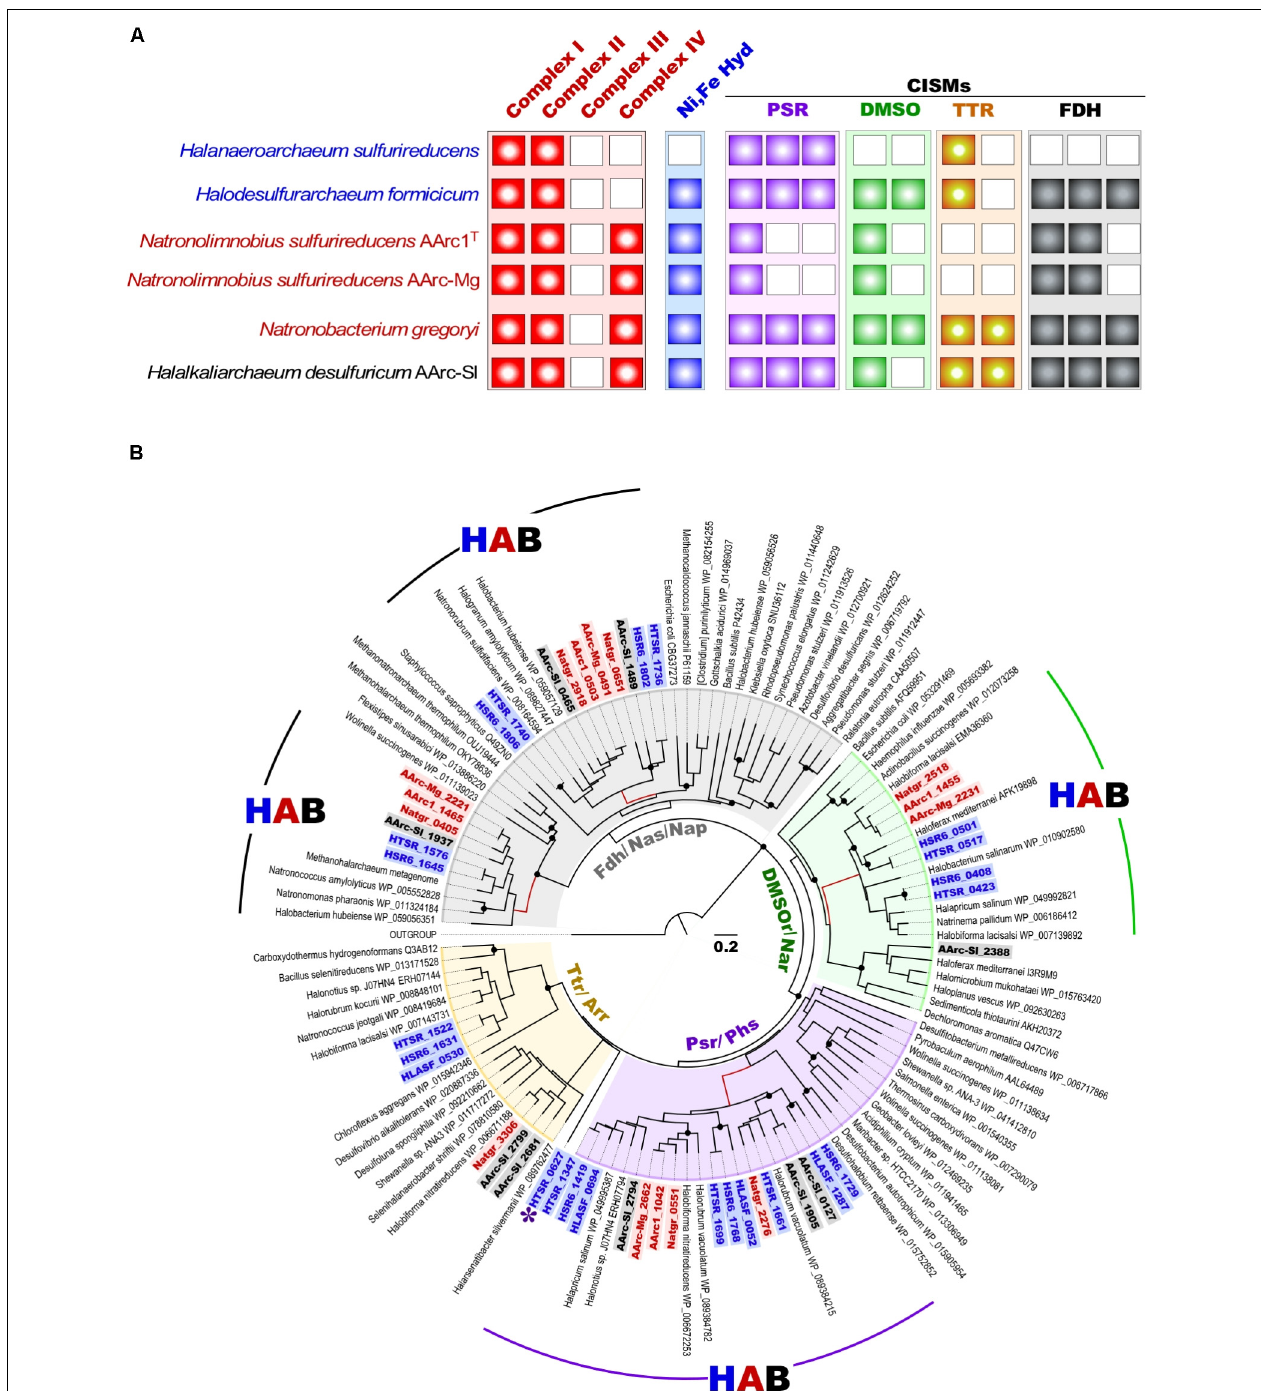
FIGURE 5 | (A) Respiratory chain components in all experimentally proven sulfur-reducing haloarchaea; (B) Maximum Likelihood phylogenetic tree of CISM catalytic subunits A. Totally 118 sequences were taken for the CISM analysis. The tree with the highest log likelihood is shown. Locus tags of CISM proteins of sulfur-reducing members of the order Halobacterales (blue), Haloferacales (black) and Natrialbales (red) are highlighted in bold. Unknown CISM family is shown by asterisk. Abbreviations used: DMSO/Nar, DMSO/nitrate reductase family; Fdh/Nas/Nap/, assimilatory nitrate reductase/formate dehydrogenase family; HAB, Haloarchaeal Branch; HLASF, Halanaeroarchaeum sulfurireducens HSR2 T ; HSR6, Halodesulfuriarchaeum formicicum HSR6 T ; HTSR, Halodesulfuriarchaeum formicicum HTSR1; Natgr, Natronobacterium gregoryi ; Ni, Fe Hyd, [NiFe] uptake hydrogenase; Psr/Phs, polysulfide/thiosulfate reductase family; Ttr/Arr, tetrathionate/arsenate reductase family. Scale bar is 0.2 amino acid substitutions per site. White boxes indicate that no homolog was detected (A) . Filled circles at the nodes indicate the bootstrap values > 70% (1000 bootstrap iterations).